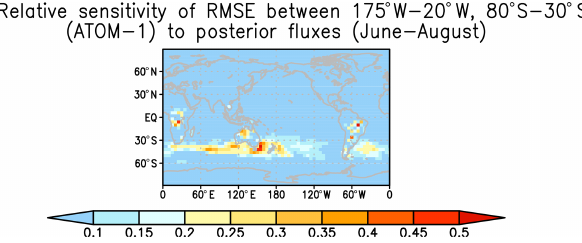
Figure B9. The relative sensitivity of RMSE of posterior CO 2 to NBE over land and air–sea net carbon exchange over ocean at every grid point. The RMSE is calculated against aircraft CO 2 observations from ATom 1 between 175–20 ◦ W, 80–30 ◦ S. The adjoint model is carried out over June–August 2016. Unit: %.